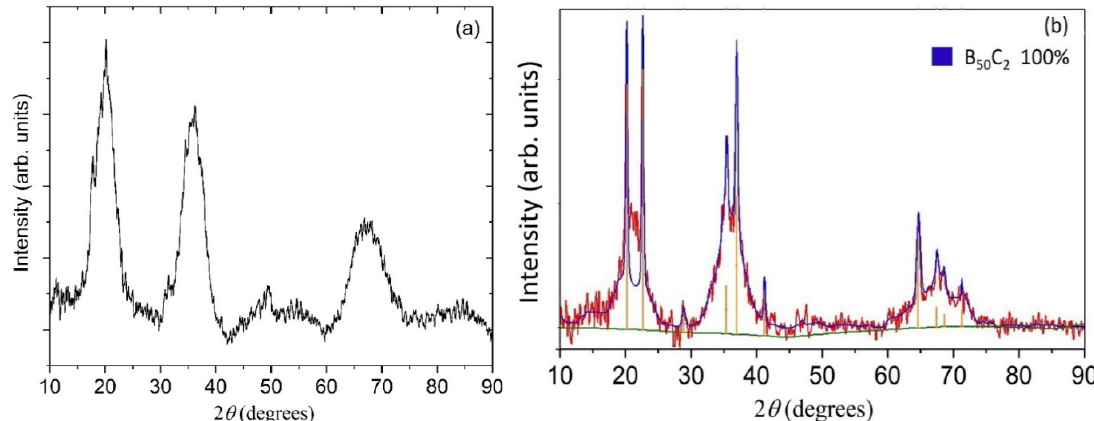
Figure 4. Glancing angle X-ray diffraction patterns for ( a ) sample BC-1 and ( b ) sample BC-2. The X-ray wavelength corresponds to Cu K- α emission ( λ = 1.54187 Å). For BC-2, the red curve is the raw data and the blue curve is the Rietveld refinement with lattice parameters a = 8.721 Å, c = 5.058 Å, and α = β = γ = 90 °.